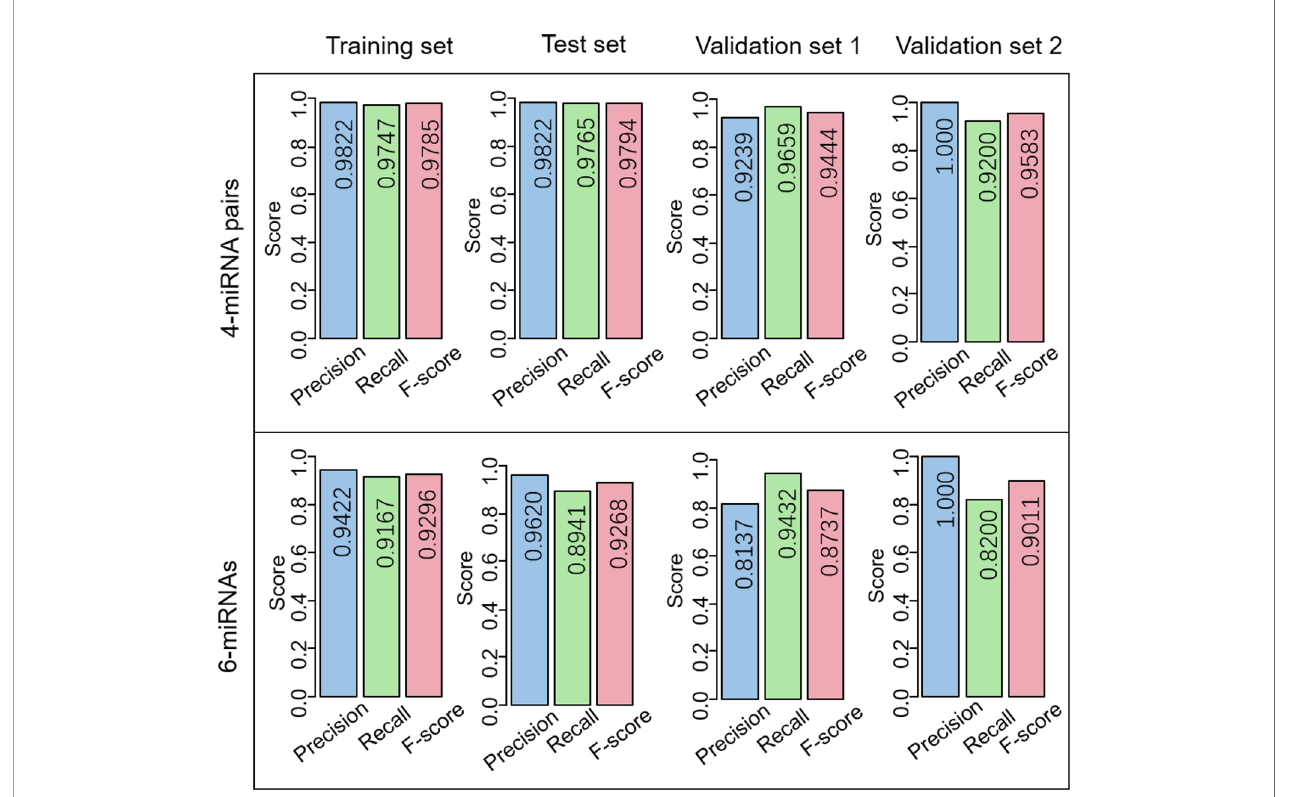
FIGURE 5 | Comparison of the performance of the 4-miRNA pair signature and the 6-miRNA signature. Precision, recall, and F-score are used for evaluation.